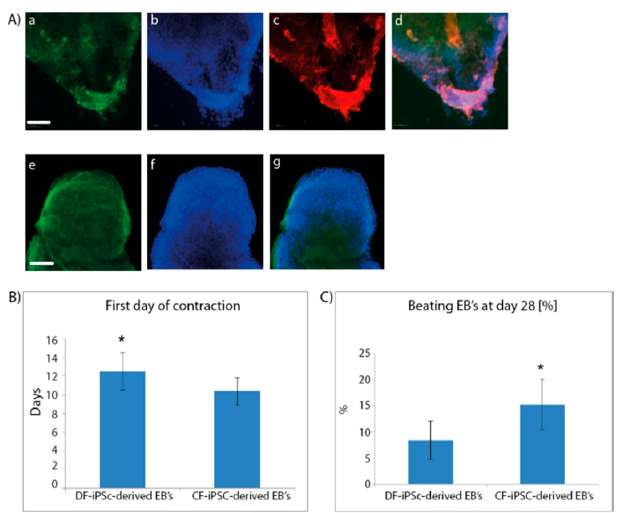
Figure 2. Immunofluorescence staining of cardiac proteins in iPSC-derived cardiomyocytes at day 28 of cells’ spontaneous di ff erentiation. ( A ) Microdissected contracting areas were stained for typical myofilament proteins. Cells were labeled with antibodies specific to myosin ( a ), troponin ( c ), and α -actinin ( e ). DAPI staining of the nuclei; ( b , f ). Merged images; ( d , g ). Scale bars ( a – g ), 100 µ m. ( B,C ) ( n = 11). Cardiac di ff erentiation; Plated EBs were monitored over 4 weeks of culture for ( B ) the onset of the first contracting areas ( * p = 0.02). Number of contracting EBs were counted out of the total number of plated EBs (( C ), * p = 0.009).